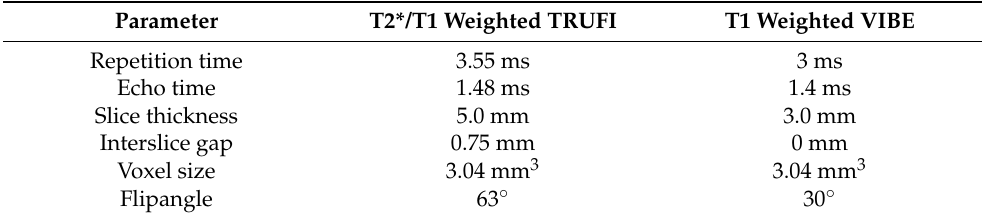
Table 2. Parameters of T2*/T1 weighted TRUFI sequence for iron oxide (left) and T1 weighted VIBE sequence for hibiscus tea powder